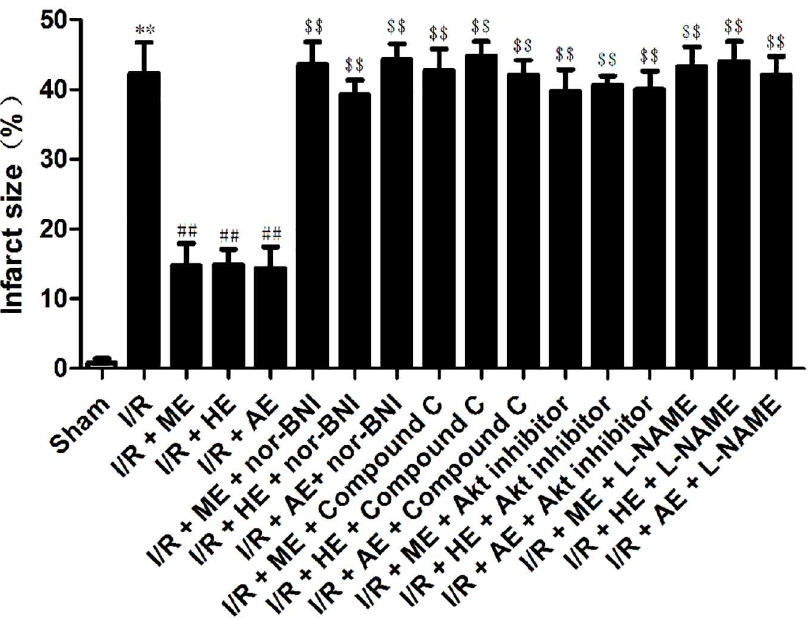
Fig 2. Effects of exercisetraining on infarct size after I/R. Values are expressedas %infarct size. All of the results are expressedas the mean ± SEM. I/R, 30 min of ischemiaand 120 min of reperfusion;I/R + ME, moderate intensity exercise for 8 wk before I/R; I/R + HE, high intensity exercise for 8 wk before I/R; I/R + AE, acute exercise before I/R; I/R + ME+ nor-BNI, moderate intensity exercise for 8 wk before I/R plus nor-BNI (2.0 mg/kg); I/R + HE + nor-BNI, high intensity exercise for 8 wk before I/R plus nor-BNI (2.0 mg/kg); I/R + AE + nor-BNI; acute exercise before I/R plus nor-BNI (2.0 mg/kg); I/R + ME + CompoundC, moderate intensity exercise for 8 wk before I/R plus Compound C (20 mg/kg); I/R + HE + CompoundC, high intensity exercise for 8 wk before I/R plus Compound C (20 mg/kg); I/R + AE + CompoundC, acute exercise before I/R plus Compound C (20 mg/kg); I/R + ME + Akt inhibitor,moderate intensity exercise for 8 wk before I/R plus Akt inhibitor(0.3 mg/kg); I/R + HE + Akt inhibitor,high intensity exercise for 8 wk before I/R plus Akt inhibitor(0.3 mg/kg); I/R + AE + Akt inhibitor,acute exercise before I/R plus Akt inhibitor(0.3 mg/kg); I/R + ME + L-NAME, moderate intensity exercise for 8 wk before I/R plus L-NAME (30 mg/kg); I/R + HE + L-NAME, high intensity exercise for 8 wk before I/R plus L-NAME (30 mg/kg); I/R + AE + L-NAME, acute exercise before I/R plus L-NAME (30 mg/kg). n = 8, ** P < 0.01vs. sham, ## P < 0.01vs. I/R, $$ P < 0.01vs. I/R+ME, I/R+HE,